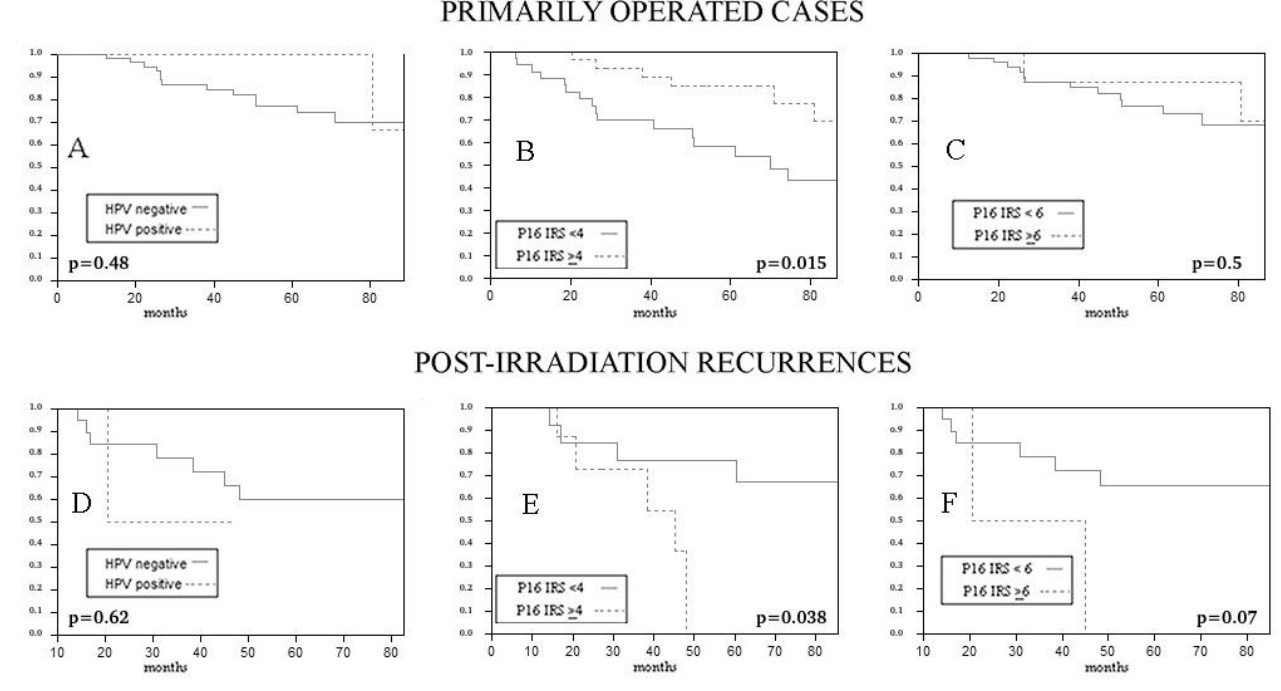
Figure 4. Impact of HPV DNA (( A ) p = 0.48 at Log-Rank; D p = 0.62 at Log-Rank) and of p16 expression (( B ) IRS ≥ 4 cut-off p = 0.015 at Log-Rank; ( C ) IRS ≥ 6 cut-off p = 0.5 at Log-Rank; ( E ) IRS ≥ 4 cut-off p = 0.038 at Log-Rank test; ( F ) IRS ≥ 6 cut-off p = 0.07 at Log-Rank), when available, on OS in primarily operated cases ( A – C ) and in salvage surgeries ( D – F ). p16 overexpression with a IRS score >4 is associated with better survival in primaries ( B ) and to a worse survival in recurrences ( E